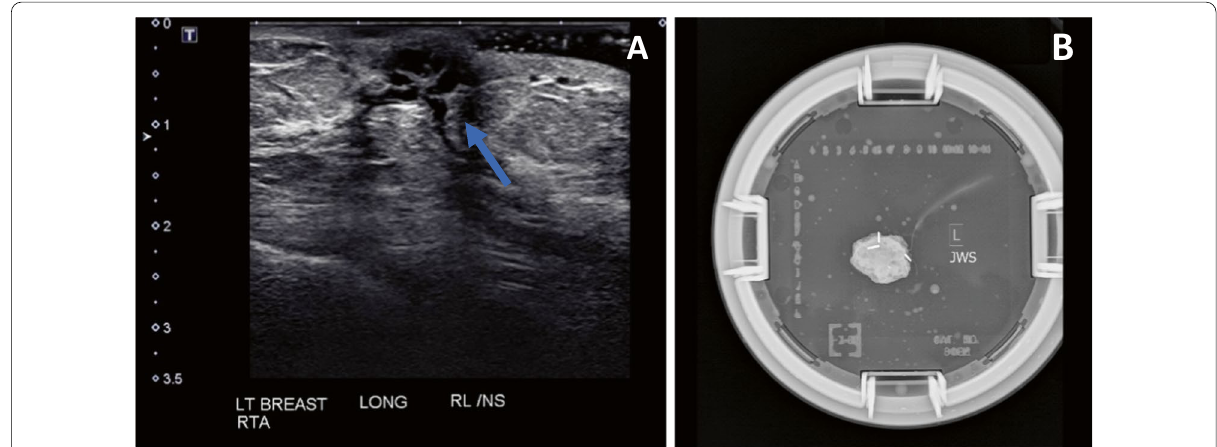
Fig. 3 65-year-old female with clear nipple discharge, sonographic evaluation showing hypoechoic lesion in the left retroareolar region at the 5:00 to 6:00 ( A , blue arrow), BIRADS 4 was assigned. Ultrasound-guided ATEC vacuum assisted core biopsy yielded IDP with benign features. Image B